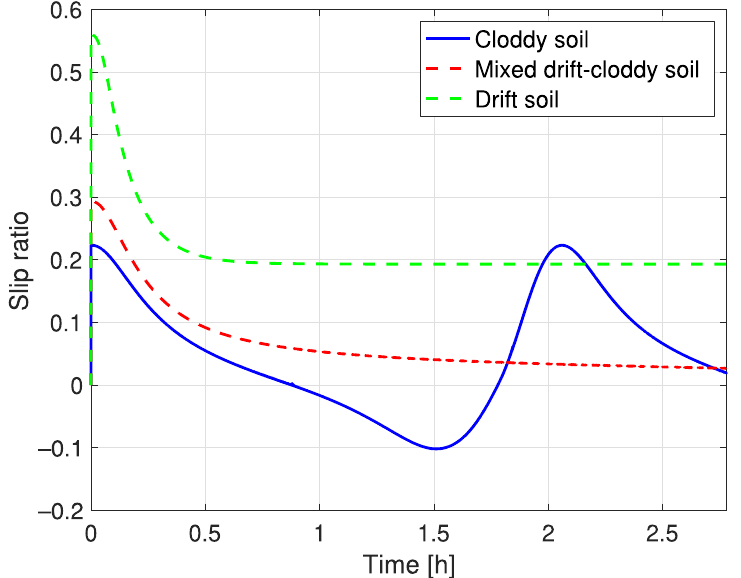
Figure 9. Rover’s longitudinal slip 𝜎 on a 20° slope, with constant steering angle 𝛿 = 4° and adaptive speed 𝑉̅.